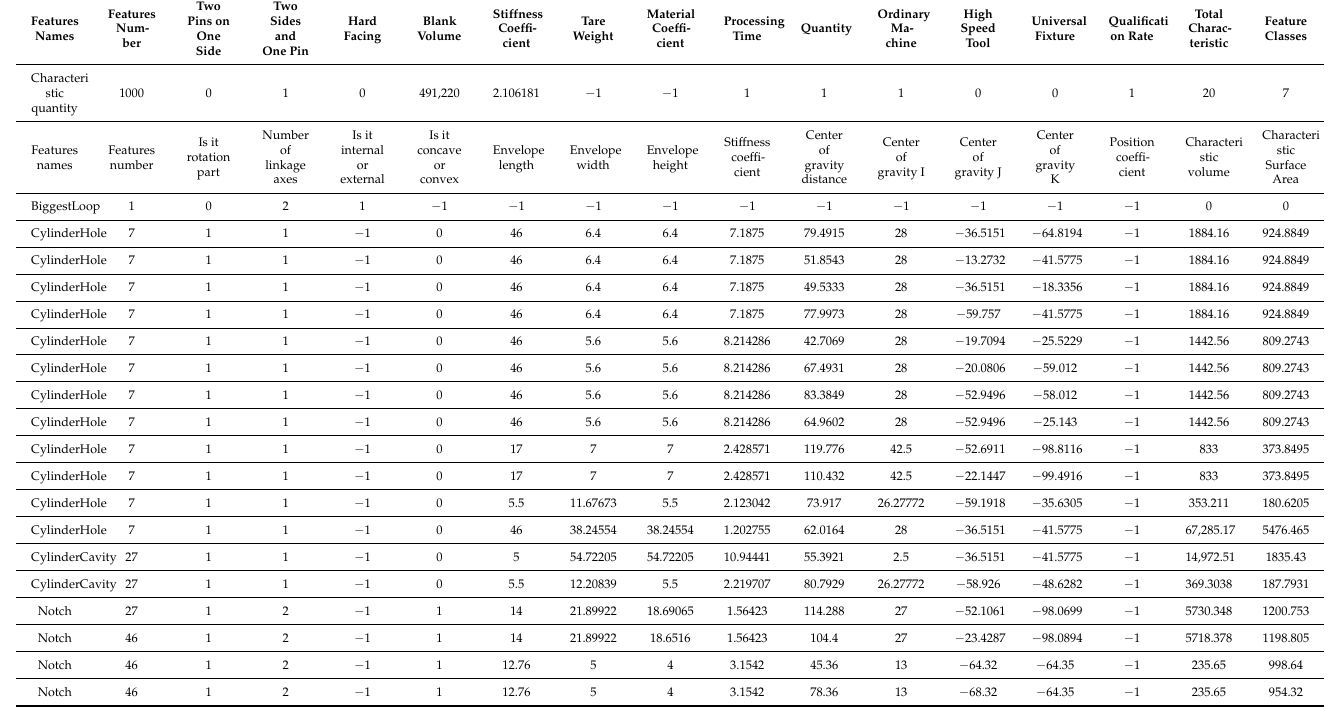
Table 7. The first half of the feature recognition results based on syntactic pattern recognition.